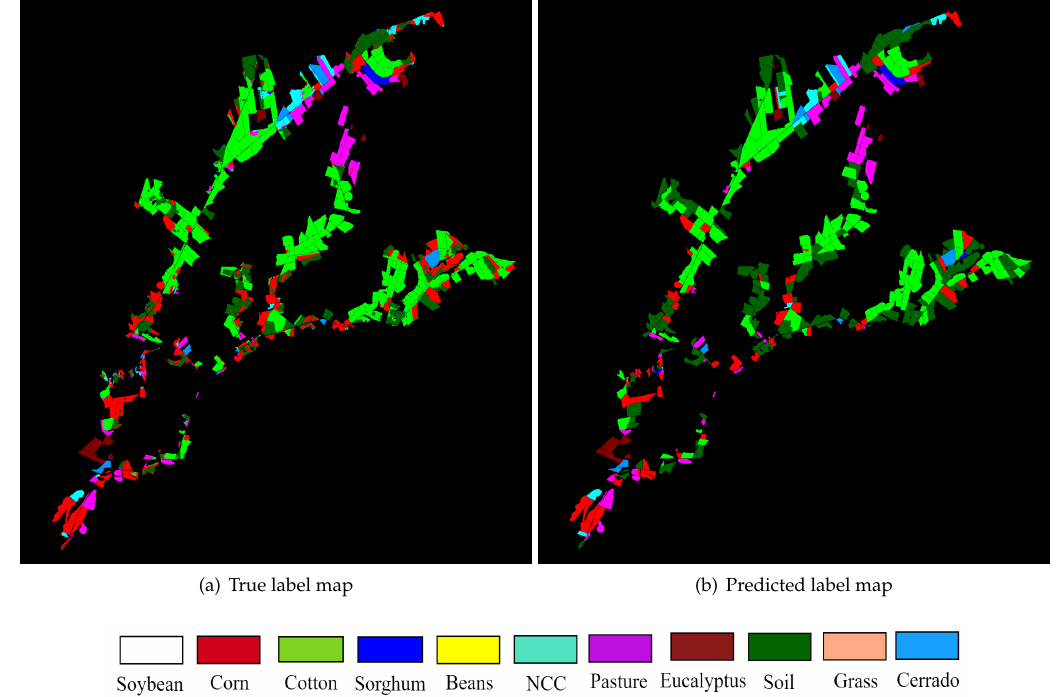
Figure 10. Classification map of sequence 2 in Campo Verde